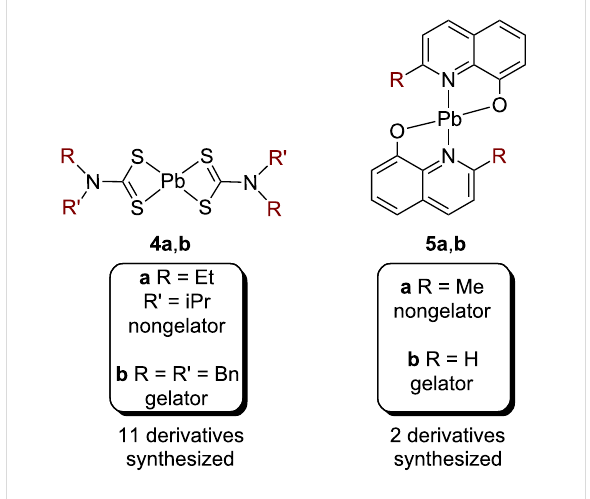
Figure 6: New gelator scaffolds identified by predicting crystal mor-